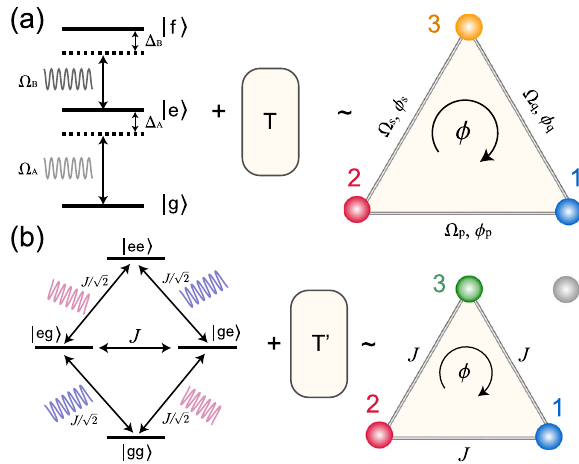
Fig. 1 Realization of CCI with a hybrid digital – analog approach. a A three-level system (a qutrit) driven by two detuned external fi elds (described by a Hamiltonian of H 0 ), when combined with specially designed digital modules (the T block) constructed from discrete quantum gates, can be used to realize the Hamiltonian H hosting an inherent CCI: Te (cid:2) iH 0 t T y (cid:4) e (cid:2) iHt , with a gauge-invariant phase ϕ . For consistency with the literature, we relabel the states of the qutrit as g j i ; e j i ; f j i ¼ 1 ; 2 ; 3 . b In a similar way, combining the natural evolution of two resonant qutrits driven by two external fi elds (with identical amplitudes and phases, indicated by different colors) with certain digital modules can result in a CCI in a subspace of the system. Here 1, 2, and 3 correspond to gg j i , ge j i , and eg j i , respectively. The gray sphere beside the state of three represents a dark state that is decoupled from the evolution of the system (see Methods section).